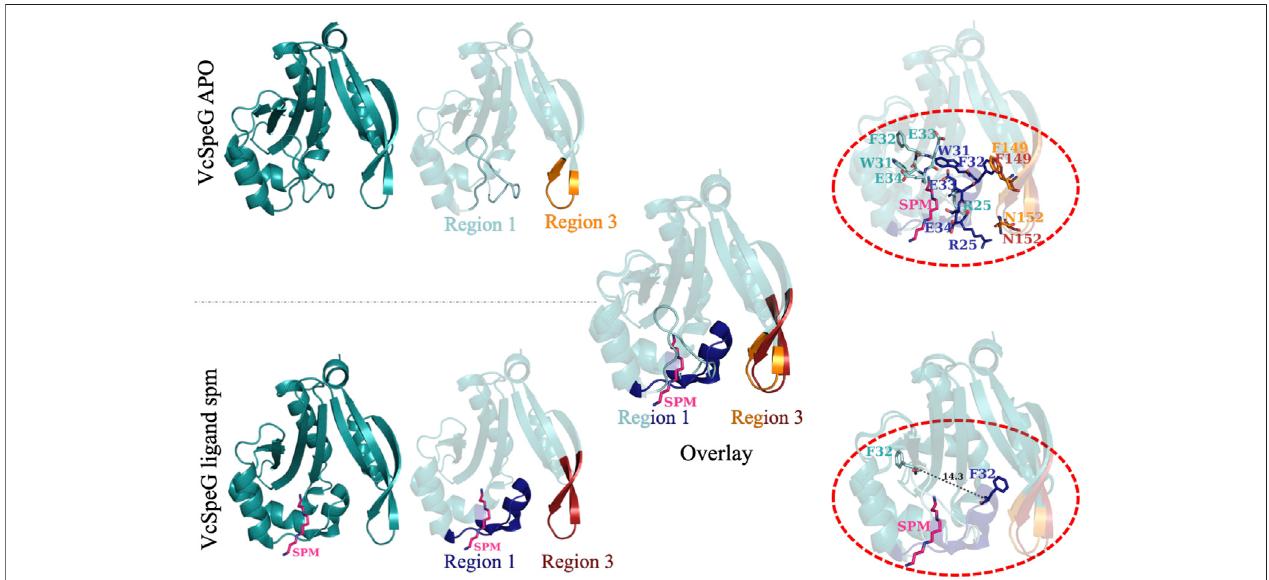
FIGURE 4 | Comparison of structural changes of the allosteric loop of the VcSpeG protein in absence and presence of spermine. The VcSpeG monomer in presence(PDBID:4mi4)andabsenceofspm(PDBID:4jjx)isshowninribbondiagrams.Thespmligandisshownaspinksticksandnitrogensareindarkblue.Region1 in the apo form is shown in cyan, but the sameregion in the spm-bound structure isshown in dark blue. Region 3 from the apo structure is inorange and is in red for the spm-bound structure. An overlay of these two structures is shown to indicate movement of Region 1 when spm is present. Residues that alter their conformation signi fi cantly upon this transition (R25, W31, F32, E33, E34, F149, and N152) are shown in the top dotted oval in sticks and are colored according to structures and regions from which they are found. The bottom dotted oval shows the distance between the C α of F32 in the apo- and spm-bound structures is 14.3